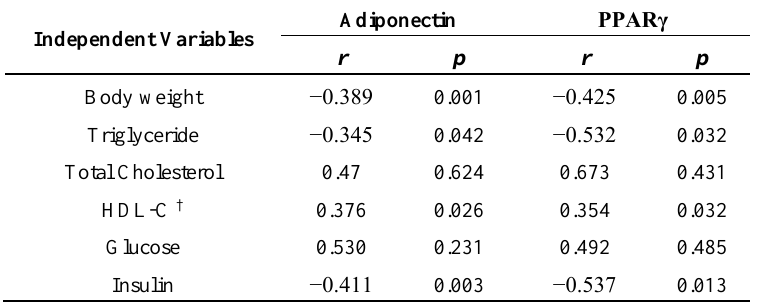
Table 4. Correlation analysis of adiponectin mRNA, PPARγ † mRNA with different serum parameters. Adiponectin PPARγ Independent Variables r p r p Body weight −0.389 0.001 −0.425 0.005 Triglyceride −0.345 0.042